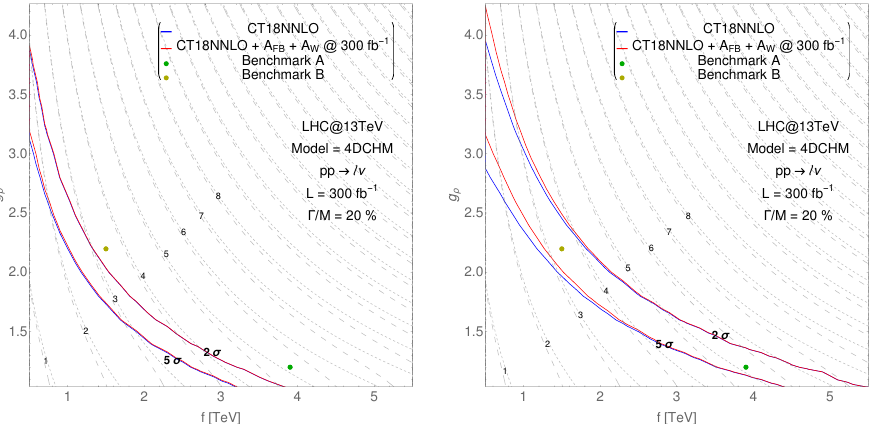
Figure 5 . Exclusion and discovery limits at 300 fb − 1 for the peak (left) and for the dip (right) for W 0 resonances with Γ /M = 20%. The short (long) dashed contours give the boson mass M Z ( M Z ’ M W ) in TeV. 3 2